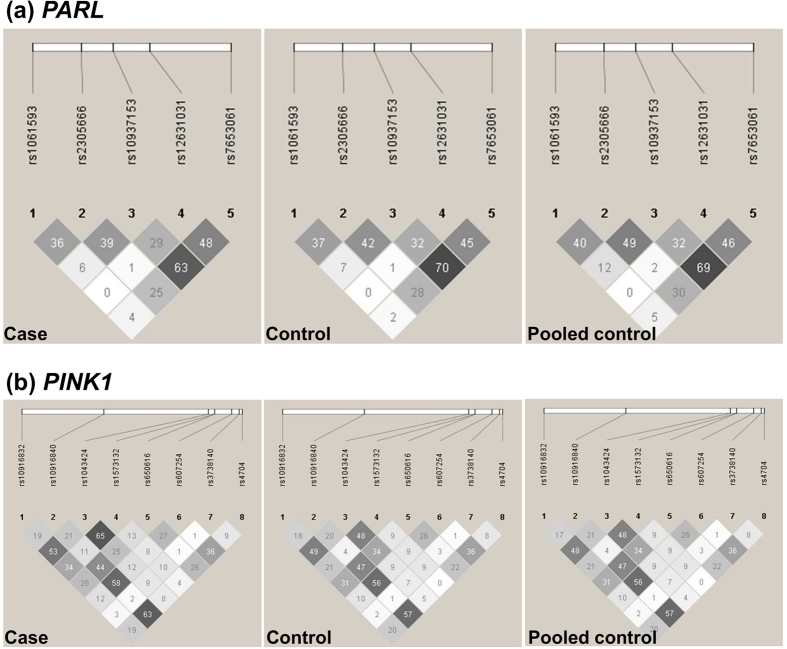
The linkage disequilibrium (LD) structures of PARL (a) and PINK1 (b) in leprosy patients and healthy controls from the Yuxi Prefecture and pooled control samples. Black squares represented high LD as measured by r2, gradually coloring down to white squares of low LD. The individual square showed the r2 value for each SNP pair (r2 value is multiplied by 100). The pooled control samples contained the reported Han Chinese without leprosy from Hunan Province (N = 984), Shanghai (N = 1526)27, and the Yuxi control samples in this study (Yuxi).